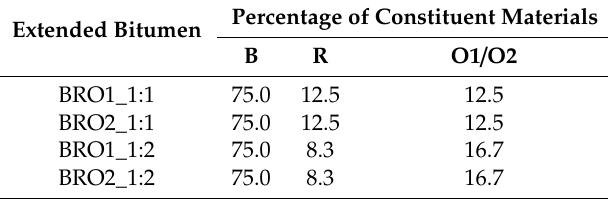
Table 1. Percentage of extended bitumens’